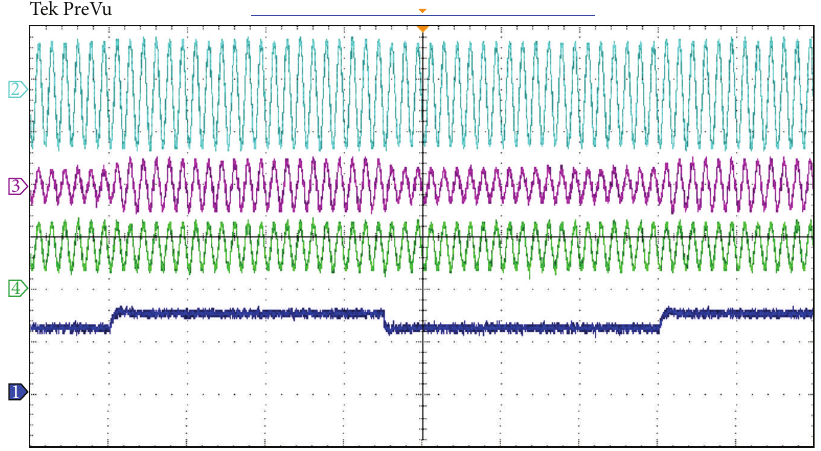
Figure 15: Operation of the system under PV perturbation. Top to bottom: Ac mains voltage (100V/div), Output current (1A/div), Sinusoidal reference (2 V/div), PV panel voltage (50V/div) . Time 100ms/div.